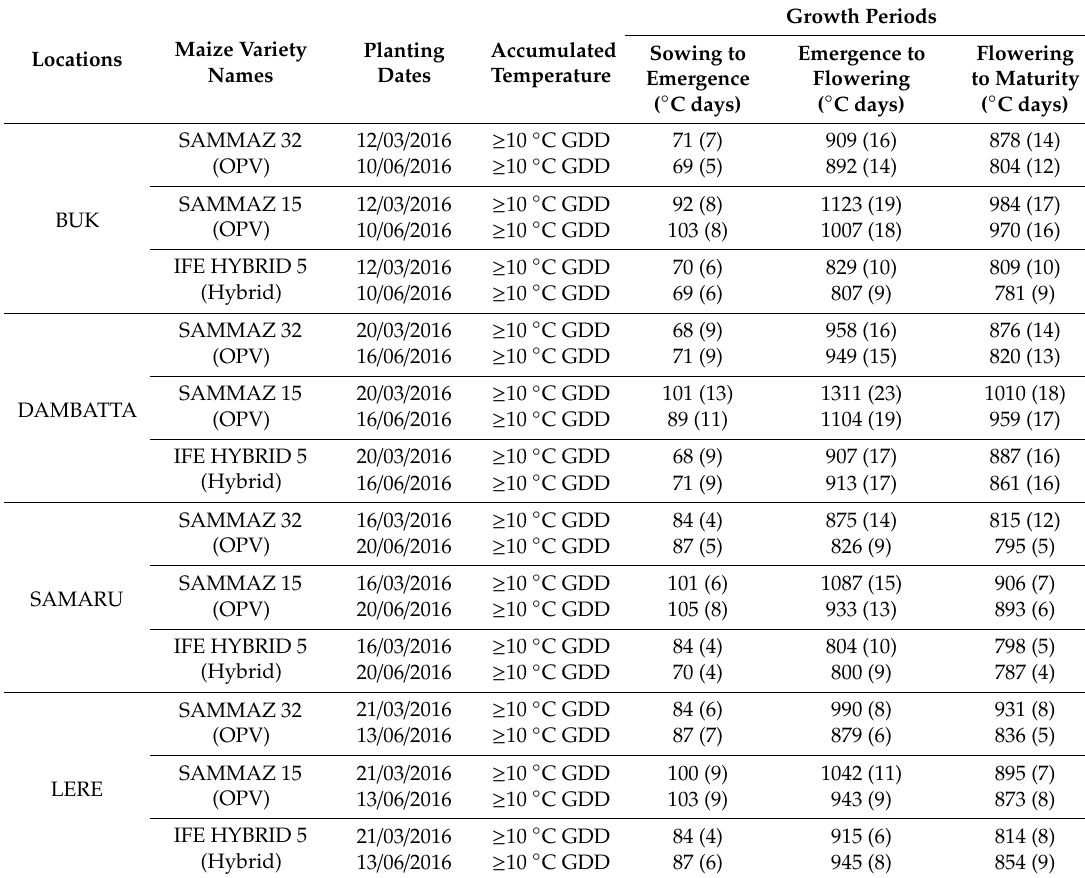
Table 2. Values of ≥ 10 ◦ C accumulated temperature and growing degree day (GDD) requirements during di ff erent growth periods with 2 planting dates for 3 maize varieties (SAMMAZ 32, SAMMAZ 15, and IFE HYBRID 5) planted in 4 locations (Bayero University Kano (BUK), DAMARU, SAMARU, and LERE) in